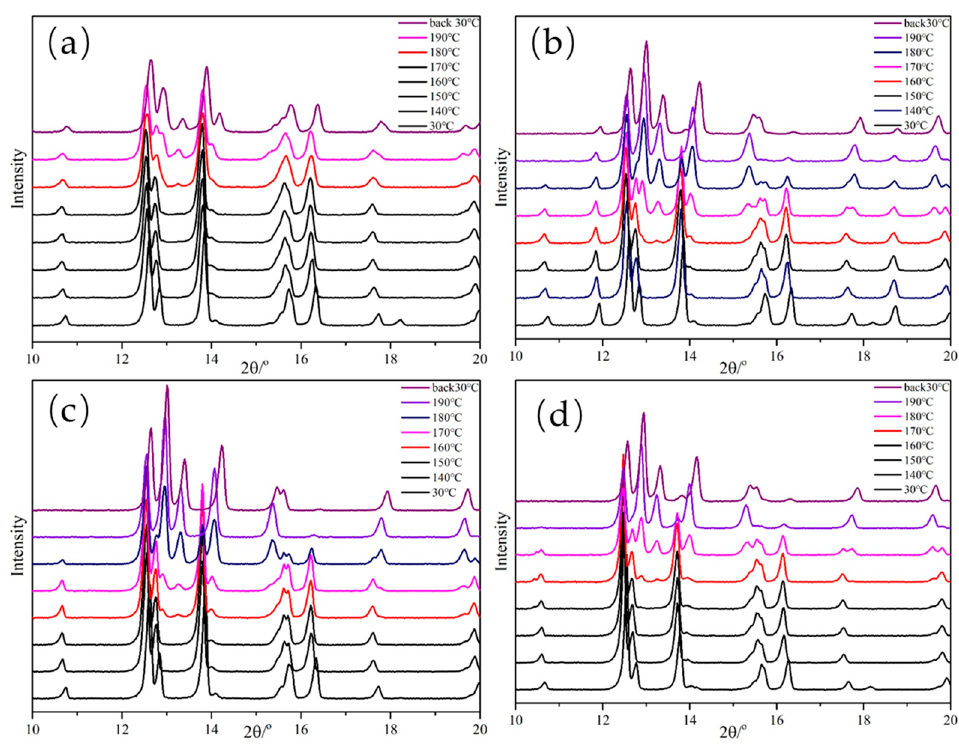
Figure 9. X ‐ ray diffraction (XRD) patterns of (a) the conformers from four polymorphs of CL ‐ 20 and (b) ε‐ CL ‐ 20 at various temperatures.